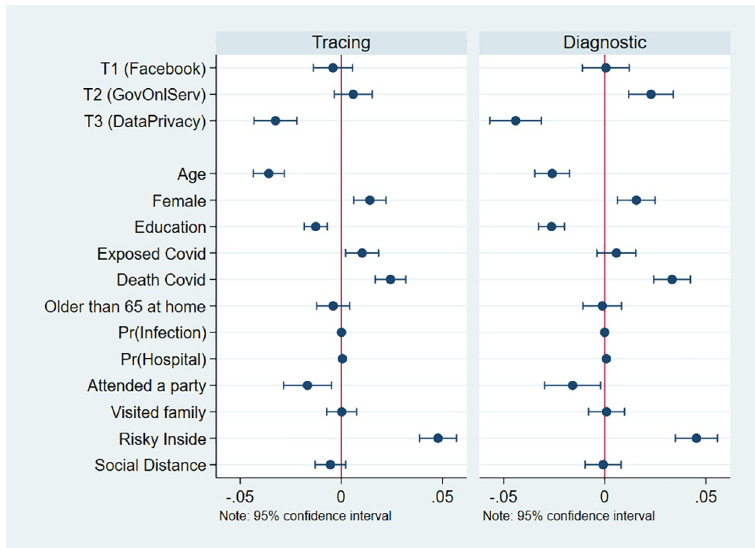
Fig 1. Treatment effects and coefficient estimates. This figure shows the Average Treatment Effects and the coefficients for the control variables. It corresponds to columns [2] and [6] in Table 2.